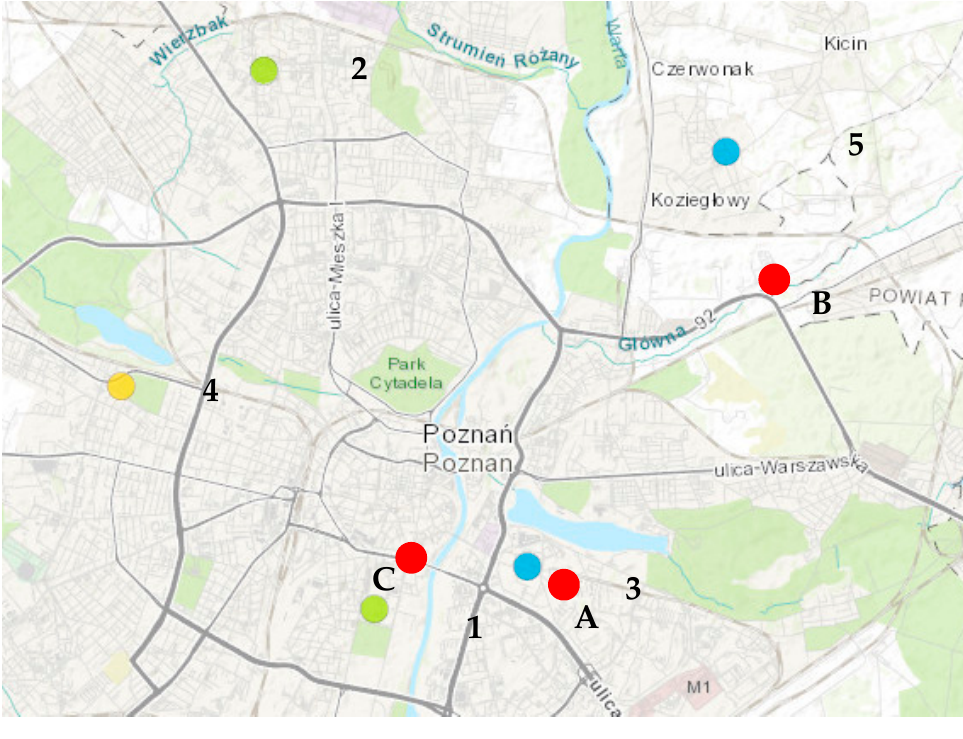
Figure 10. Measuring point and stations in Poznan.